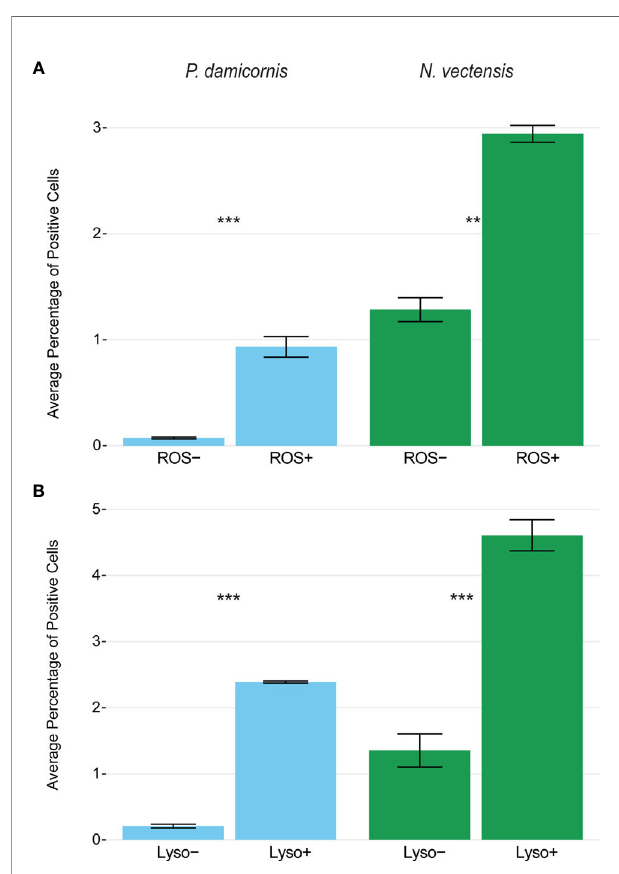
FIGURE 5 | Phagocytic cells are associated with immune cell vesicular markers for ROS (CellROX) and lysosomal vesicles (LysoTracker) in P. damicornis and N. vectensis . For each species, cells were differentially isolated and sorted based on ROS (A) or lysosomal vesicle (B) signals, and then co- incubated with beads. (A) Comparison of low and high levels of ROS in P. damicornis (blue bars) and N. vectensis (green bars). There is a signi fi cant increase in the number of cells engul fi ng beads in samples associated with high ROS levels ( P. damicornis p-value < 0.001; N. vectensis p-value < 0.01). (B) Comparison of low and high levels of lysolitic vesicle signaling in P. damicornis (blue bars) and N. vectensis (green bars). There is a signi fi cant increase in the number of cells engul fi ng beads in samples associated with high lysosomal levels ( P. damicornis p-value < 0.001; N. vectensis p-value < 0.001). P-value marks: **p < 0.01, ***p <